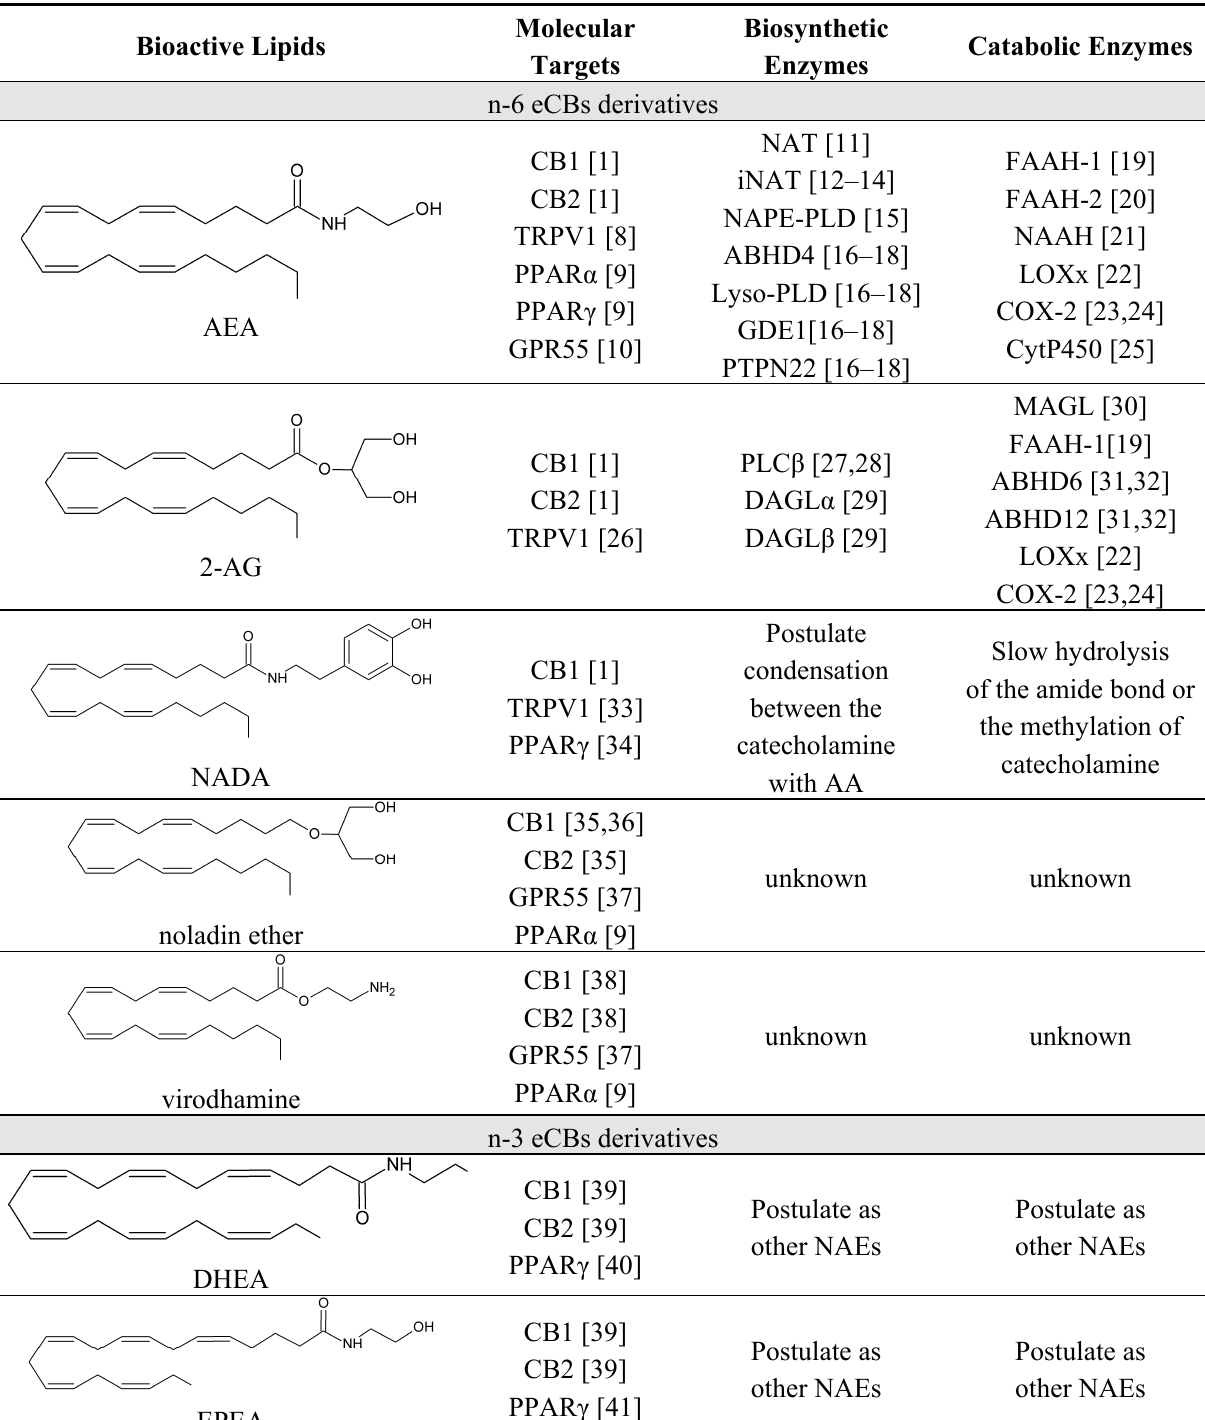
Table 1. eCBs and eCBs-like compounds, their molecular targets, biosynthetic and catabolic